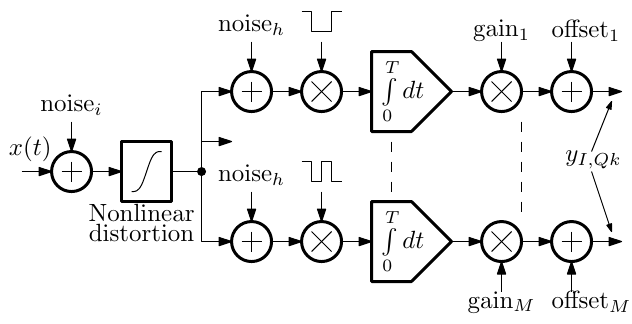
Figure 10. Simulation model of hardware error